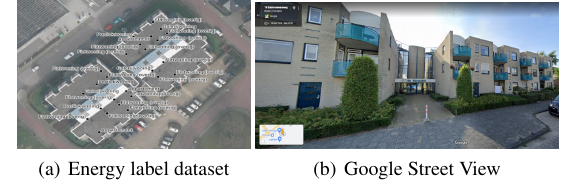
Figure 8. Example of a multi familiar residential building with several classification